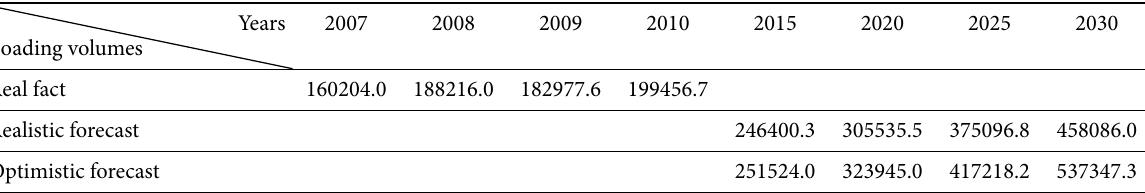
Table 3. Loading volumes of the Eastern Baltic Sea region ports and their forecast up to the year 2030, thous.